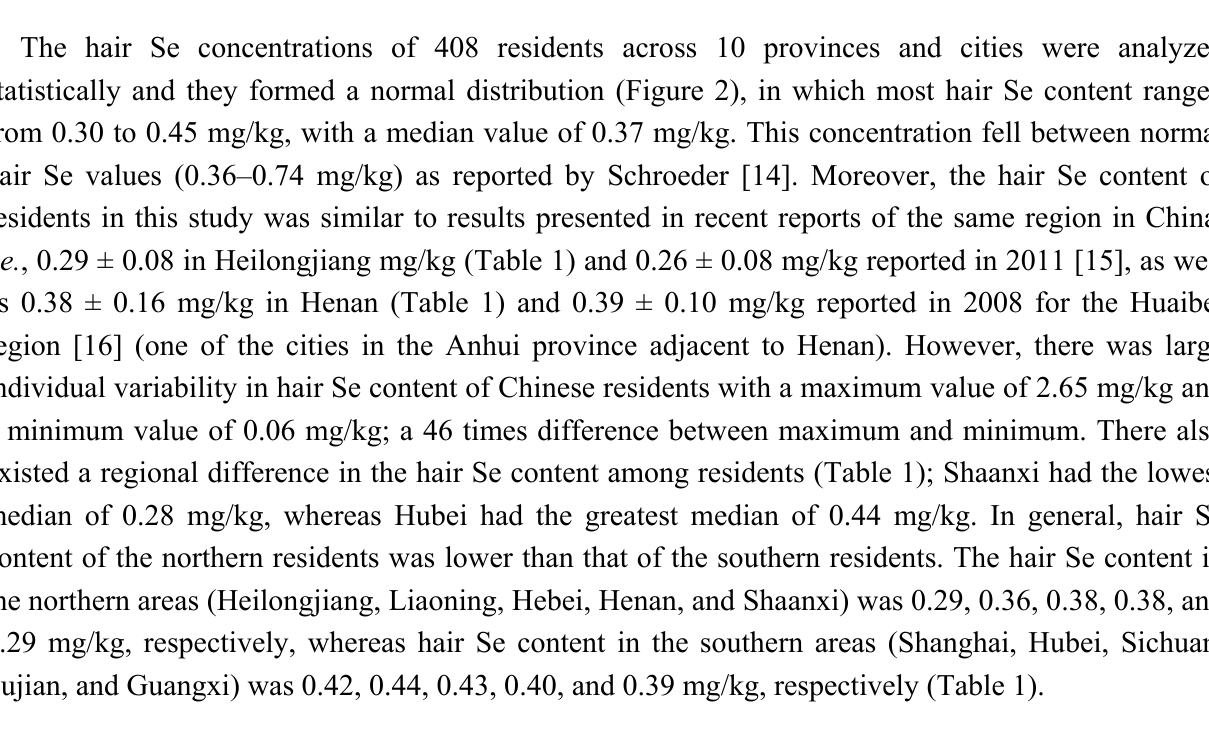
Figure 2. The statistical distribution of all residents’ hair Se concentrations in this